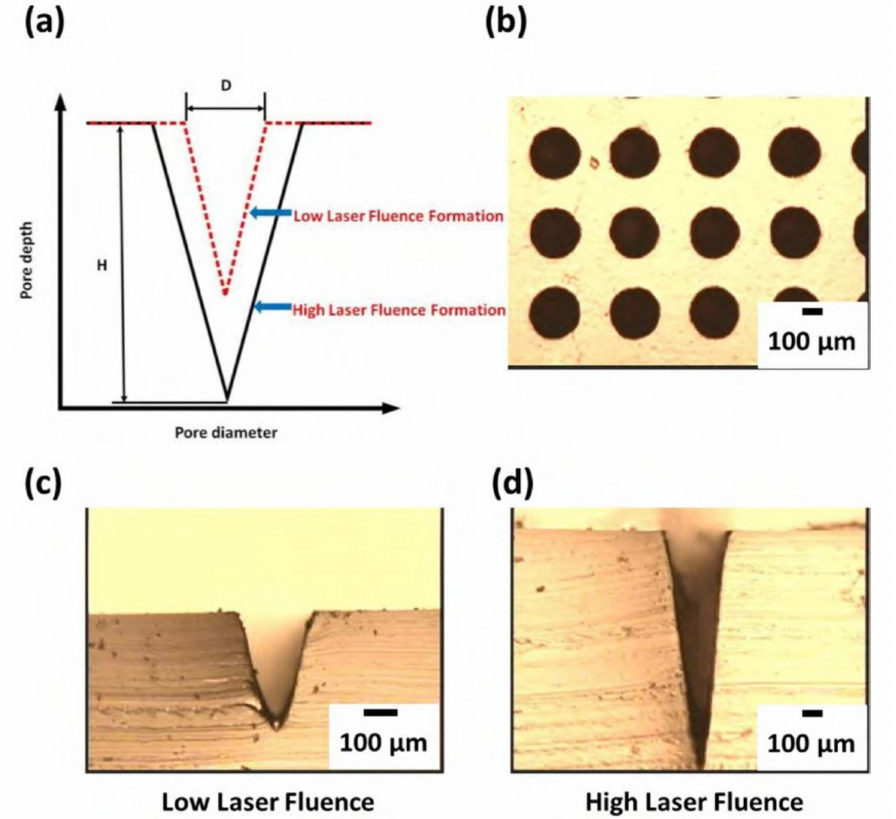
Figure 6. ( a ) Schematic different laser fluence with Gaussian-like distribution for the ablated PMMA profile formation, ( b ) the PMMA holes array formed at 3-W laser power and 114 mm s − 1 scanning speed for one pass; the cross-sectional optical micrographs of the PMMA mold formed at ( c ) low fluence and ( d ) high